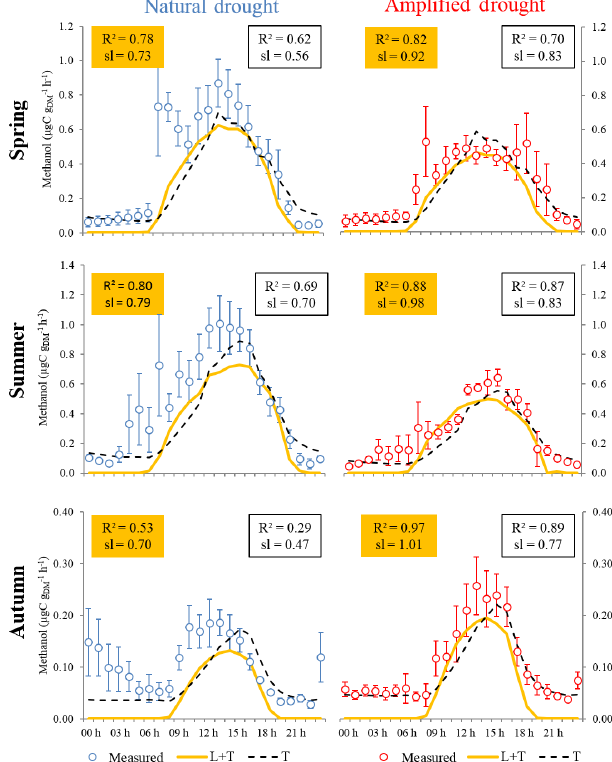
Figure 5. Diurnal pattern of measured methanol emission rates. Points represent measured emission, the yellow line corresponds to modeled emission rates according to the L + T algorithm (ER L + T ) and the dotted line corresponds to modeled emission rates according to the T algorithm (ER T ) . R 2 and slope (sl) of correlations between measured ( x axis) and modeled ( y axis) emissions are presented in the yellow frame for L + T and in the white frame for T . Correla- tions were obtained without forcing data to pass through the origin. Values are mean ± SE, n =